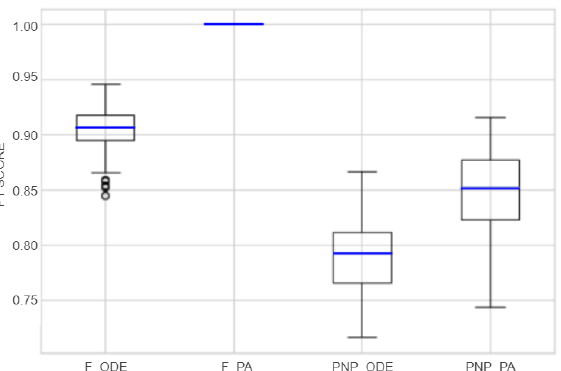
Figure 11. Boxplot with best classifiers for Furnace (F) and Pick And Place (PNP), over ODE and PA